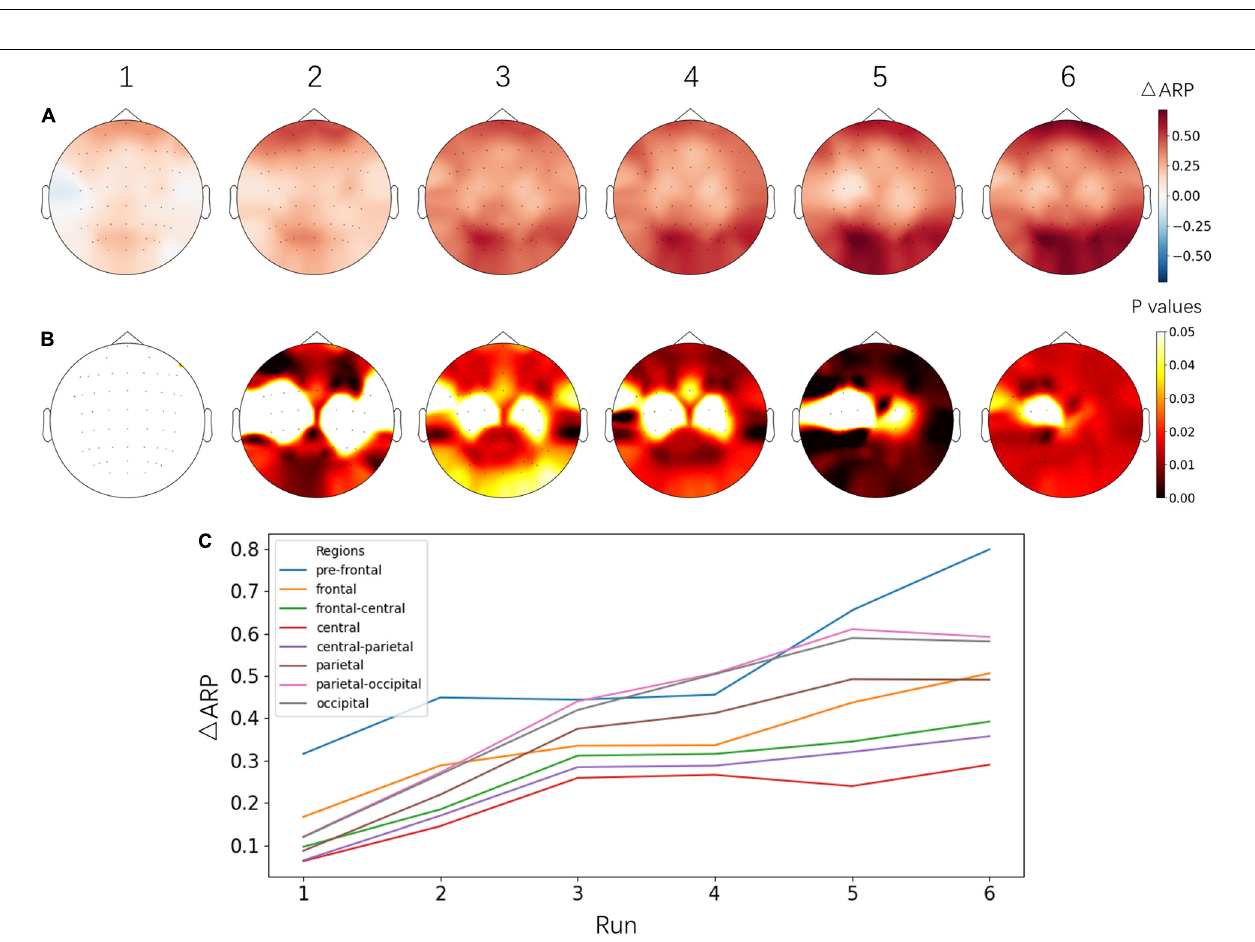
FIGURE 5 | (A) Topographical images of (cid:49) ARP between each alpha NFT run and the baseline session before NFT. (B) The significant level of (cid:49) ARP from the paired t -test – the p values of electrodes were corrected by FDR. The images in (A,B) share the same color bars on the right, respectively. (C) Line plot of (cid:49) ARP from different brain regions across six alpha NFT runs. Electrodes were grouped into 8 brain regions by their name and averaged in each region. Fp and AF: pre-frontal, F: frontal, FC: frontal- central, C: central, CP: central- parietal, P: parietal, PO: parietal-occipital, O: occipital area.